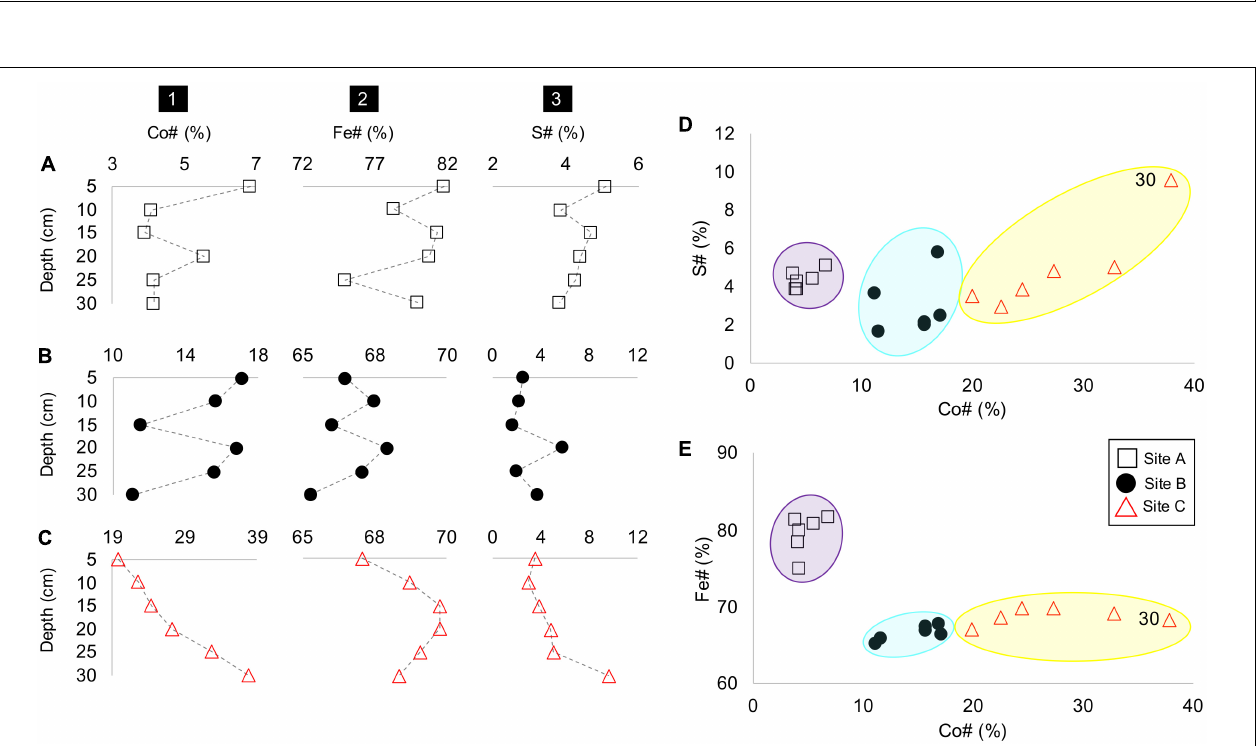
FIGURE 4 | Depth profile plots of sites A to C (rows A–C ) with the concentrations of (1) As, (2) Co and (3) Fe, and (4) the average As valence vs. depth (cm).